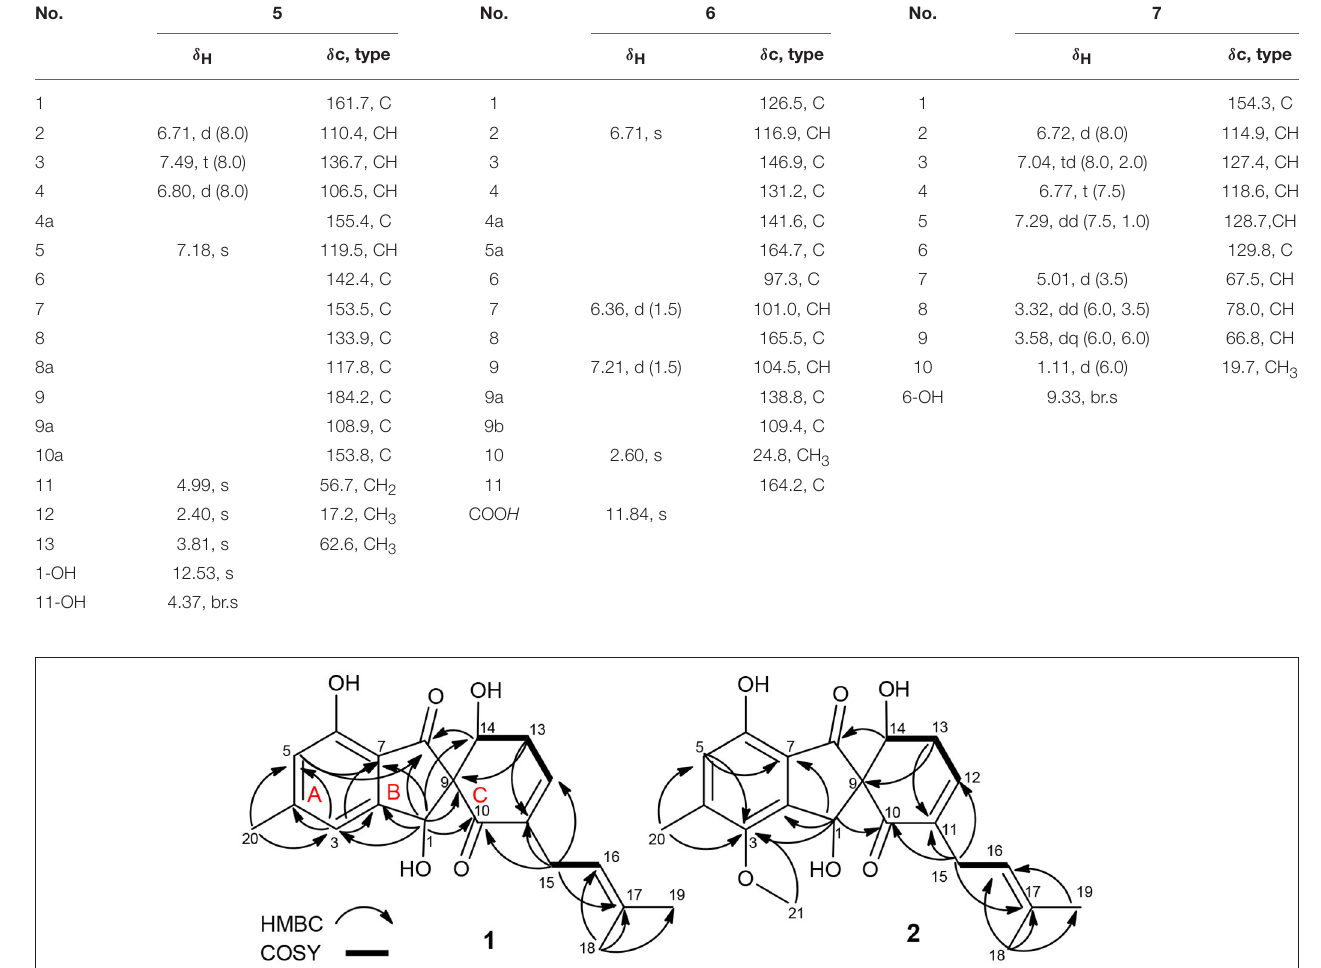
FIGURE 2 | Key COSY and HMBC correlations of 1 and 2